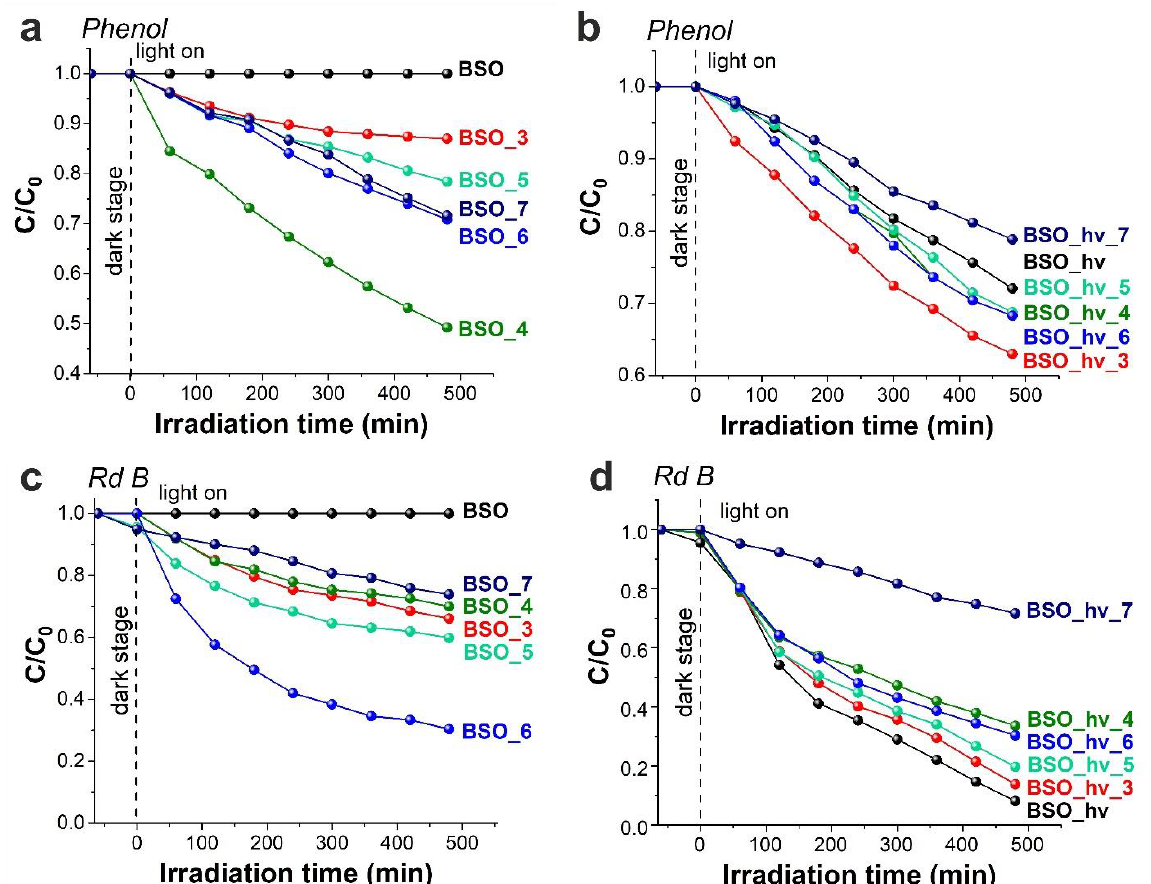
Figure 11. Kinetic curves for phenol ( a , b ) and Rd B ( c , d ) decomposition in presence of BSO ( a , c ) and BSO_hν ( b , d ) groups of samples.